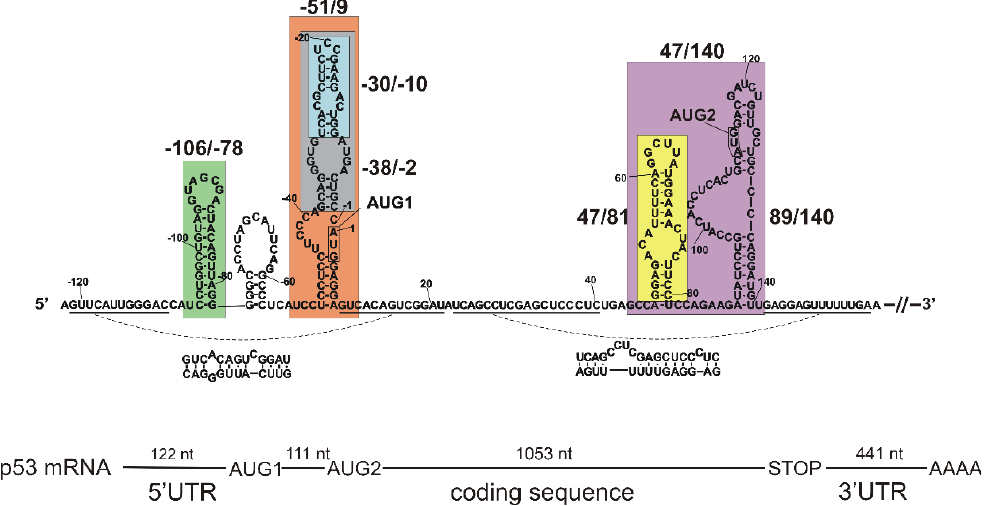
Figure 1. Secondary structure model of the 5′ -termini of mouse p53 mRNA with the analyzed elements indicated. The displayed structure consists of the first 278 nucleotides of p53 mRNA and spans the 5′ non-coding region of 122 nucleotides and a part of the coding sequence with the AUG2 initiation codon. Structural elements marked by color boxes were synthetized as separate RNA oligomers. The RNA oligomers are denoted by the numbers in the mRNA sequence of the first and the last nucleotide of each oligomer as follows: -106/-78 (green box), -51/9 (orange box), -30/-10 (blue box), -38/-2 (gray box), 47/140 (violet box), 47/81 (yellow box) and 89/140 (hairpin within a violet box, not marked by separate box). Schematic representation of the full-length mouse p53 mRNA is also shown in the figure.